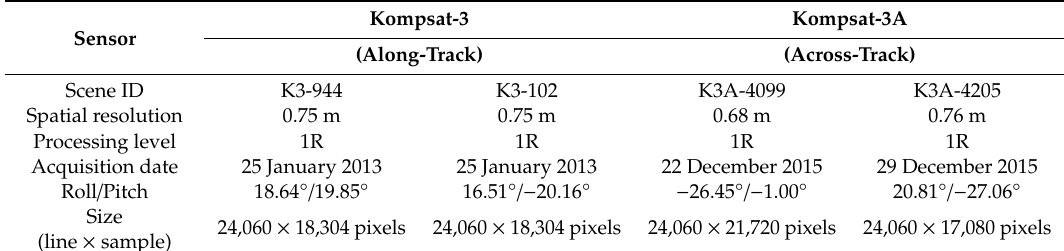
Table 1. Specifications of the tested Kompsat-3